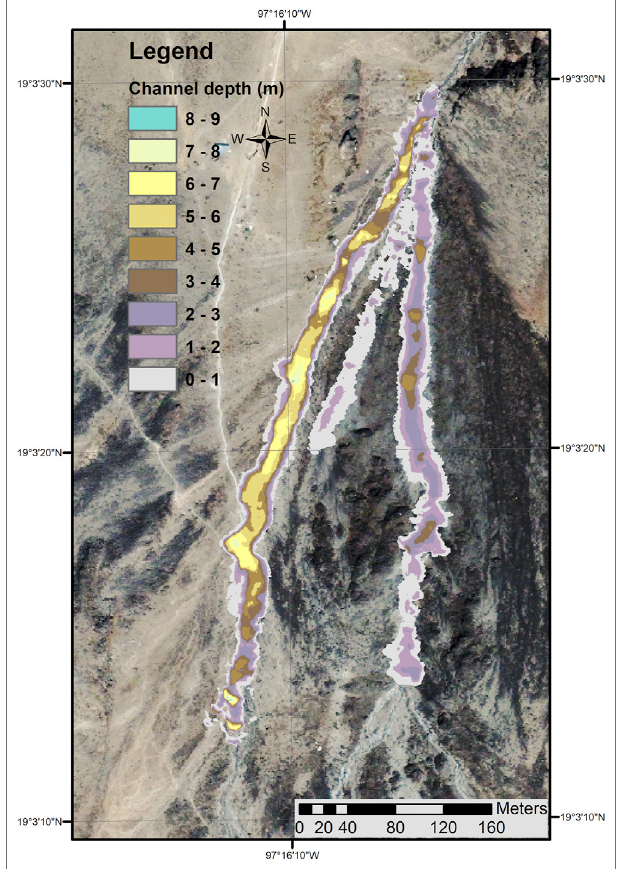
FIGURE 10 | Graphic showing the result of the pre- and post-Ernesto DEM substraction described in the text (see also Figure 9 ). The colors depict thicknesses of the excised channel material. Background is 2003 Ikonos